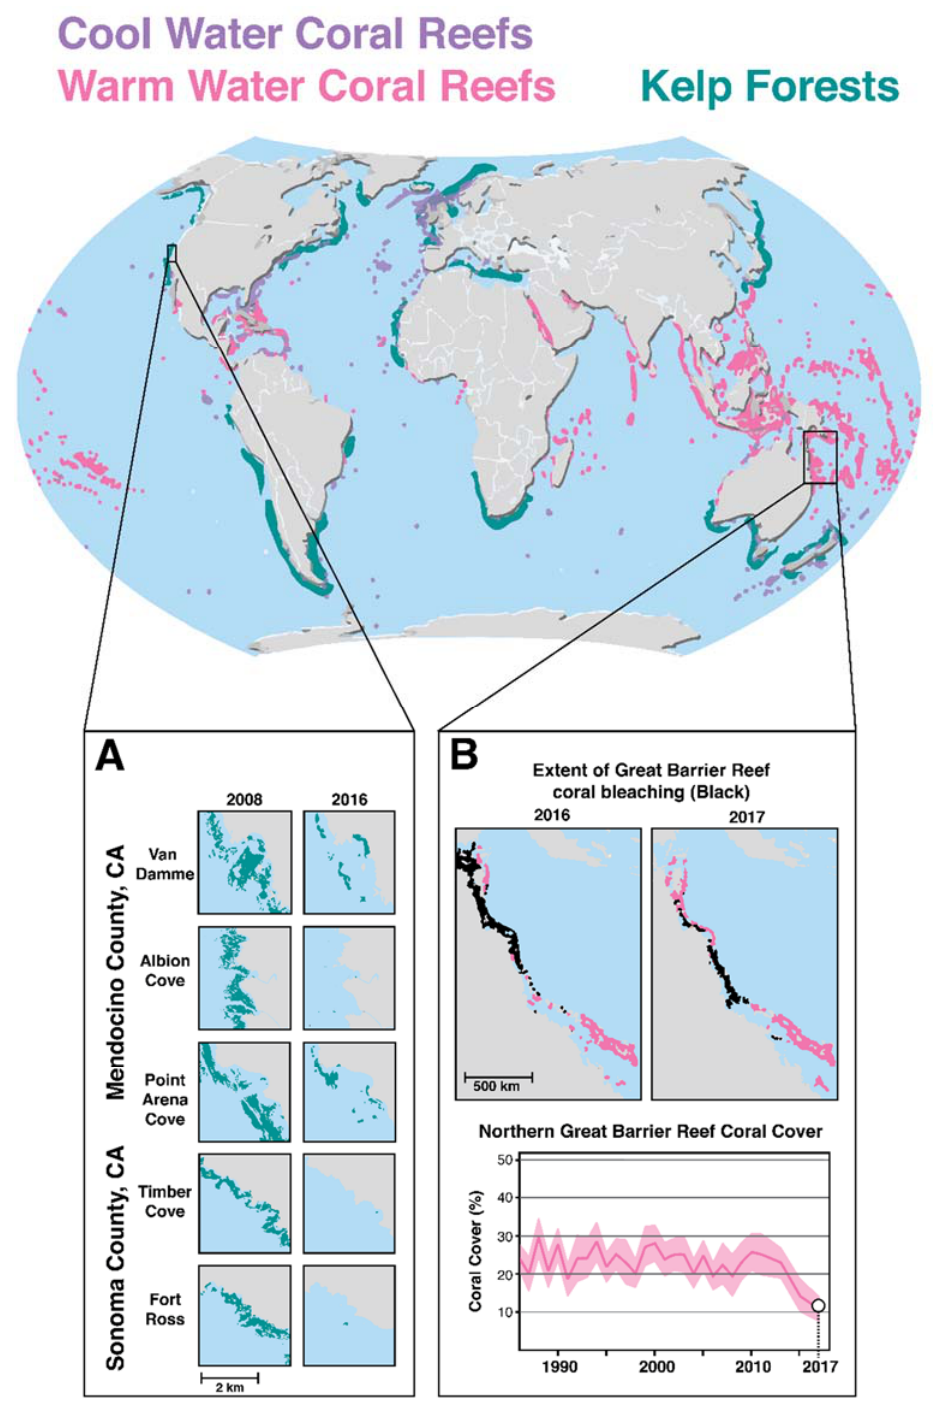
Figure 3. Global Distributions of Coral Reefs and Kelp Forests. ( A ) Presents northern California kelp forest loss from 2008 to 2016. ( B ) Presents the first consecutive severe bleaching event in Great Barrier Reef Survey history from 2016 and 2017. Sources of maps and graphs: [104,105], California Department of Fish and Wildlife Marine Management Team Aerial Surveys, and Australian Institute of Marine Science